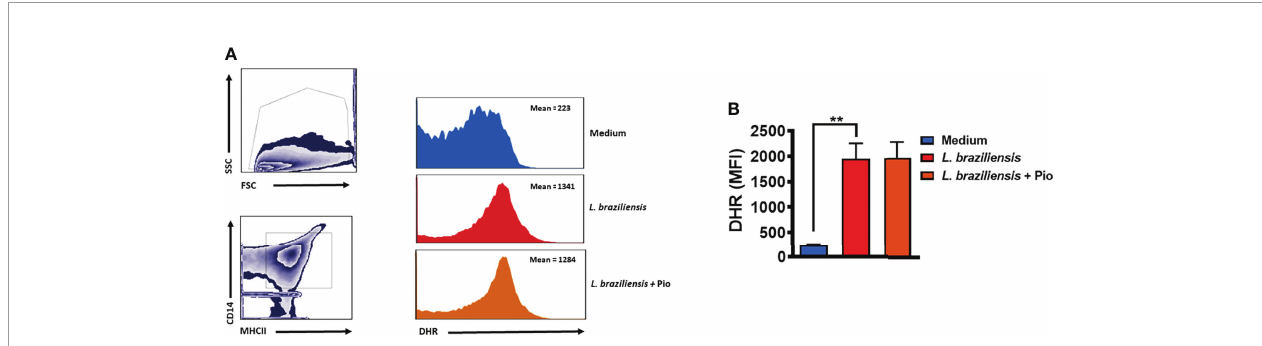
FIGURE 6 | Pioglitazone does not interfere in Leishmania braziliensis -induced reactive oxygen species (ROS) production. Monocytes from healthy subjects (HSs) (n = 5) were treated with dihydrorhodamine-123 (DHR) at 10 ng/ml for 10 min and cultured for 24 h in the presence or absence of L. braziliensis (5:1) and pioglitazone (1 m M). Cells were stained with anti-CD14 and anti-MHC-II fl uorochrome-conjugated antibodies. The mean fl uorescence intensity (MFI) of the cells was assessed by fl ow cytometry. (A) Gate strategy representative plots and histograms. (B) Mean and SD from 5 HS. Statistical analyses were performed using the ANOVA t-test. *p <